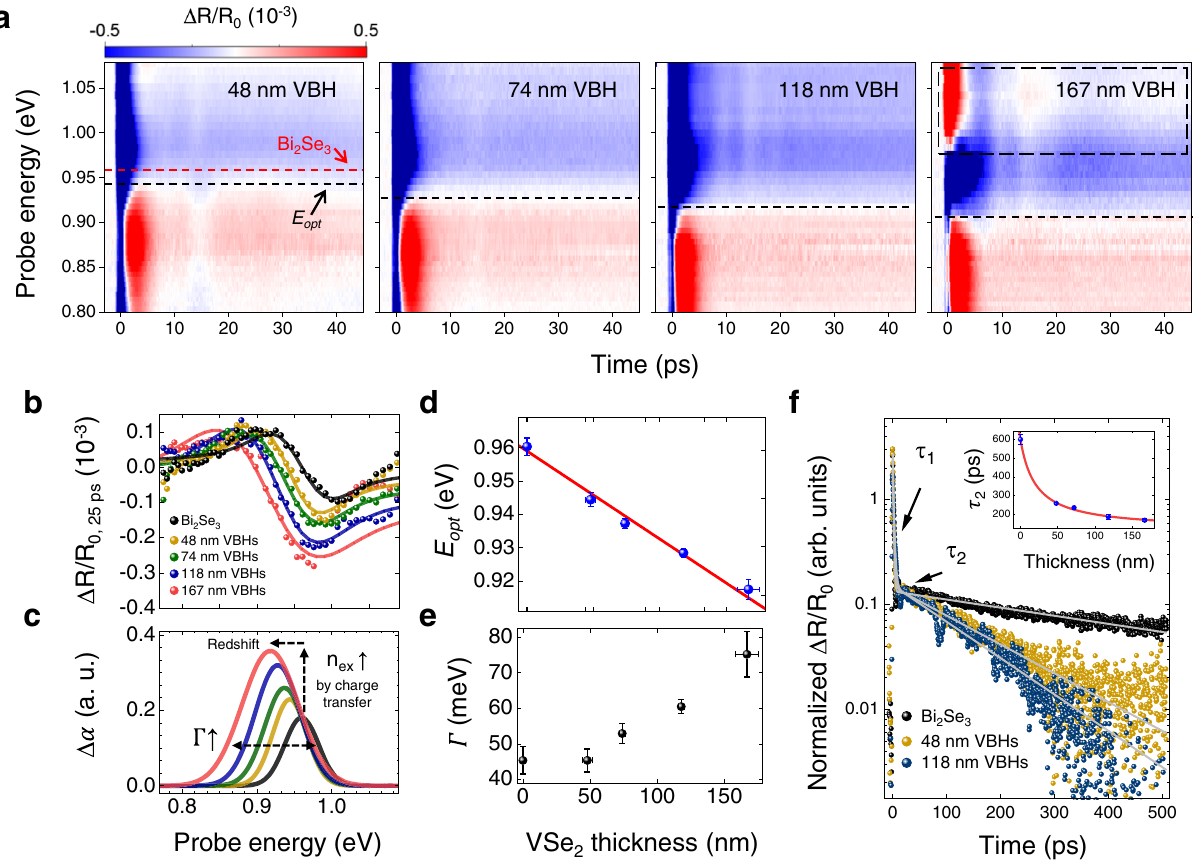
Fig. 4 VSe2-thickness-dependent electronic modulation of insulating bulk states in Bi2Se3. a 2D plots of the transient re fl ectance (TR) spectra of VSe 2 / Bi 2 Se 3 heterostructures (VBHs). The dashed horizontal lines indicate the optical transition energy ( E opt ) of 10 quintuple layer (QL) Bi 2 Se 3 (red) and VBHs (black), respectively. b Selected TR spectral features at 25 ps with fi tting curves based on Eq. (4) and ( c ) corresponding absorption changes ( Δ α ). The n ex and Γ represent the photoexcited carrier concentration and broadening factor of photoinduced absorption changes, respectively. d VSe 2 -thickness- dependent E opt obtained by fi tting from (b). The line fi t delivers a slope of 0.26 meV nm − 1 . e VSe 2 -thickness-dependent Γ of the optical transition estimated by model fi tting based on Eq. (4). f Dynamic evolution of TR signals in Bi 2 Se 3 and VBHs. The gray fi t curves indicate biexponential decays in Bi 2 Se 3 and VBHs with 48 nm and 118 nm VBH. Inset: VSe 2 -thickness-dependent interband recombination time of metastable carrier in Bi 2 Se 3 ( τ 2 ). The error bars in ( d ), ( e ), and the inset of ( f ) indicate the standard error of the fi tted values in